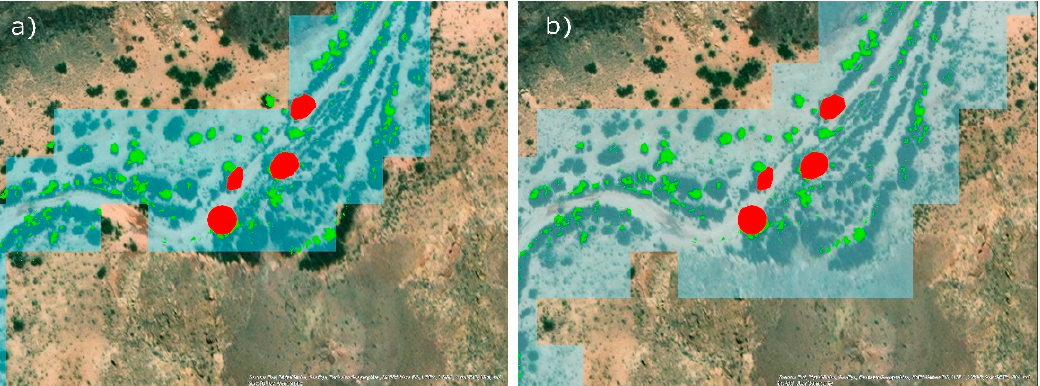
Figure 4. Riparian trees (red) and shrubs (light green) digitized using a June 2019 National Agricul ‐ tural Imagery Program (NAIP) image and overlaid with light ‐ colored, square, Landsat 30 m resolu ‐ tion pixels highlighting the raster ‐ based method of counting riparian vegetation cover for the “con ‐ servative” (( a ), left) and “best ‐ approximation” (( b ), right) area estimates.